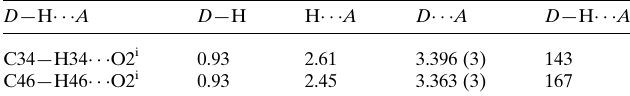
Table 1 Hydrogen-bond geometry (A˚ , (cid:2) ).